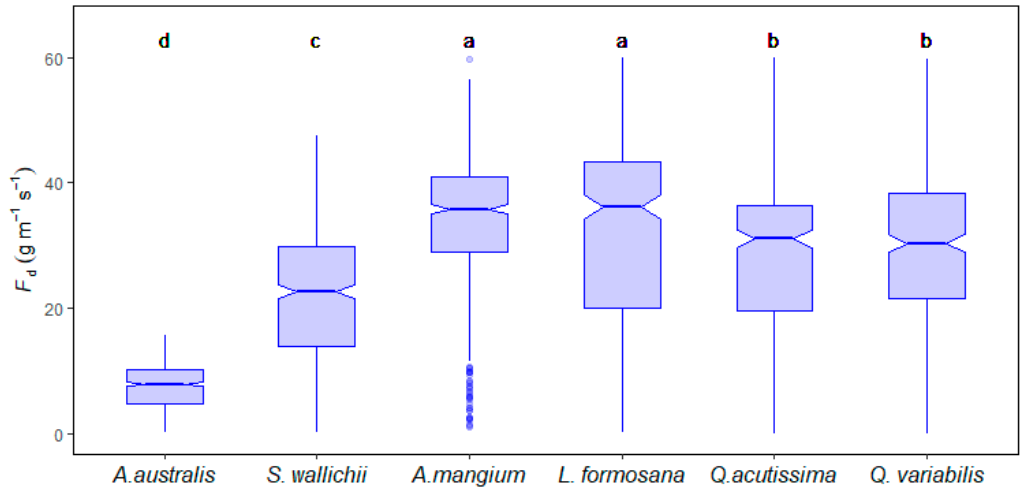
Figure 4. Maximum daily sap flow density comparison for six species. Circles indicate outliers or data points outside the whiskers, notches show approximately 95% confidence intervals around the medians. Groups with the same letter have similar means determined by a Tukey’s post hoc test.